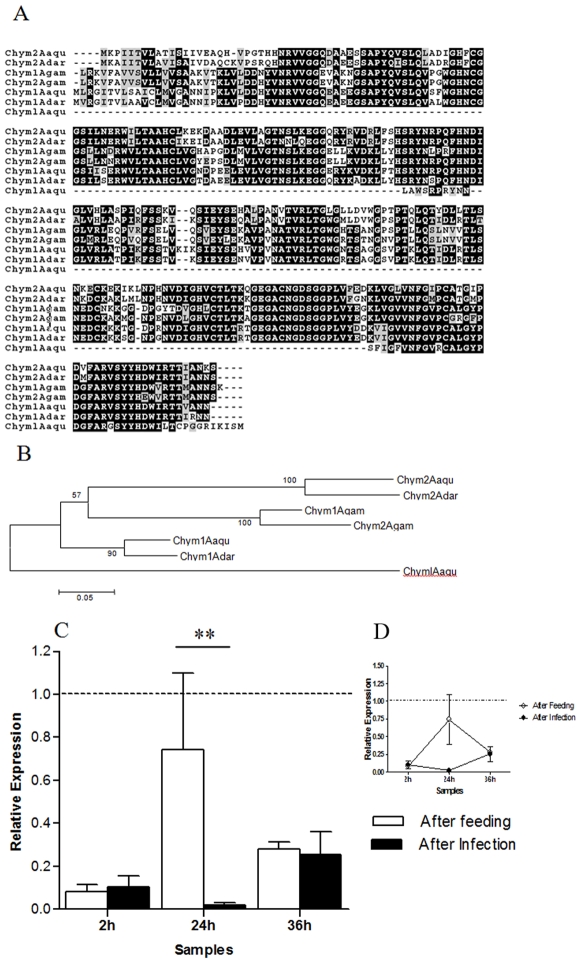
Characterization of chymotrypsin-like protease (Chymlp) induction in mosquitoes fed on sugar, blood, or infected blood.A: Multiple aminoacid sequence alignment of mosquito Chymlp sequences. B: Phylogenetic tree constructed using neighbor-joining method. C–D: Expression levels of Chymlp determined by RTPCR n sugar-fed (dotted line), blood-fed and P. vivax infected females. Chym–chymotrypsin, h–hours. Accession numbers of serine proteases from: A. aquasalis (Aaqu) (Chyml - GR486809, Chym1 - O97097, Chym2 - O97098); A. darlingi (Adar) (Chym1- O97099 and Chym2 - O97100); and A. gambiae (Agam) (Chym1 - ENSANGP00000024897, Chym2 - ENSANGP00000026162. +−: s.e.m.; * p<0.05, ** 0.03>p>0.01, *** p<0.01.